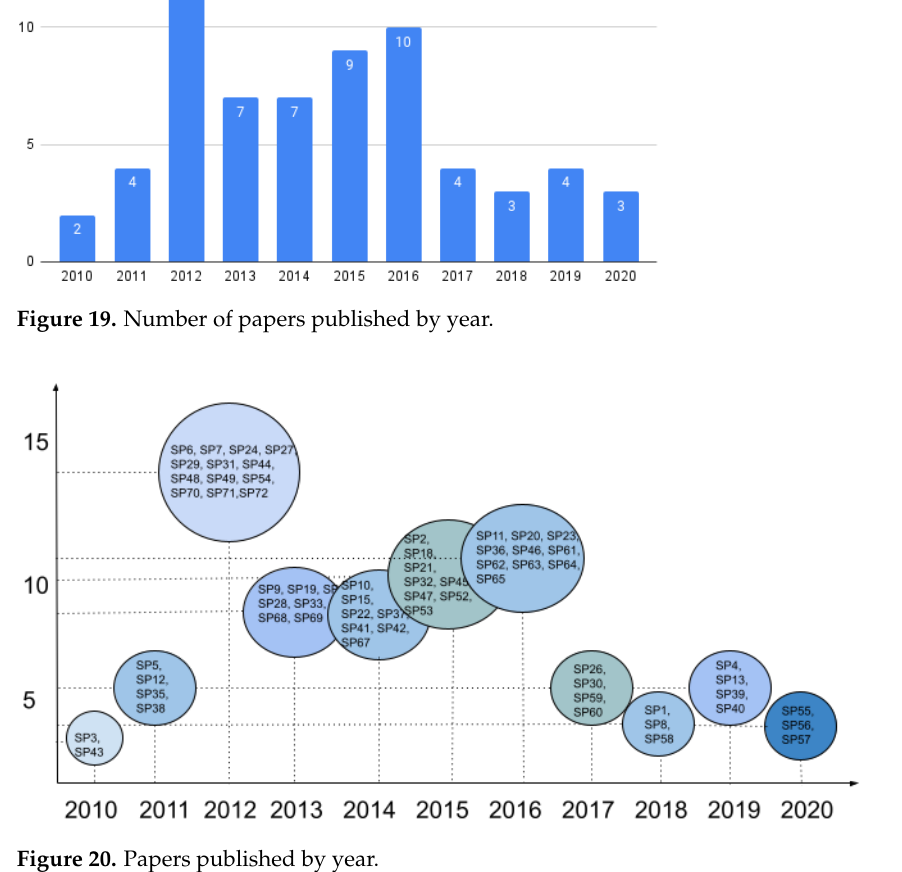
Figure 20. Papers published by